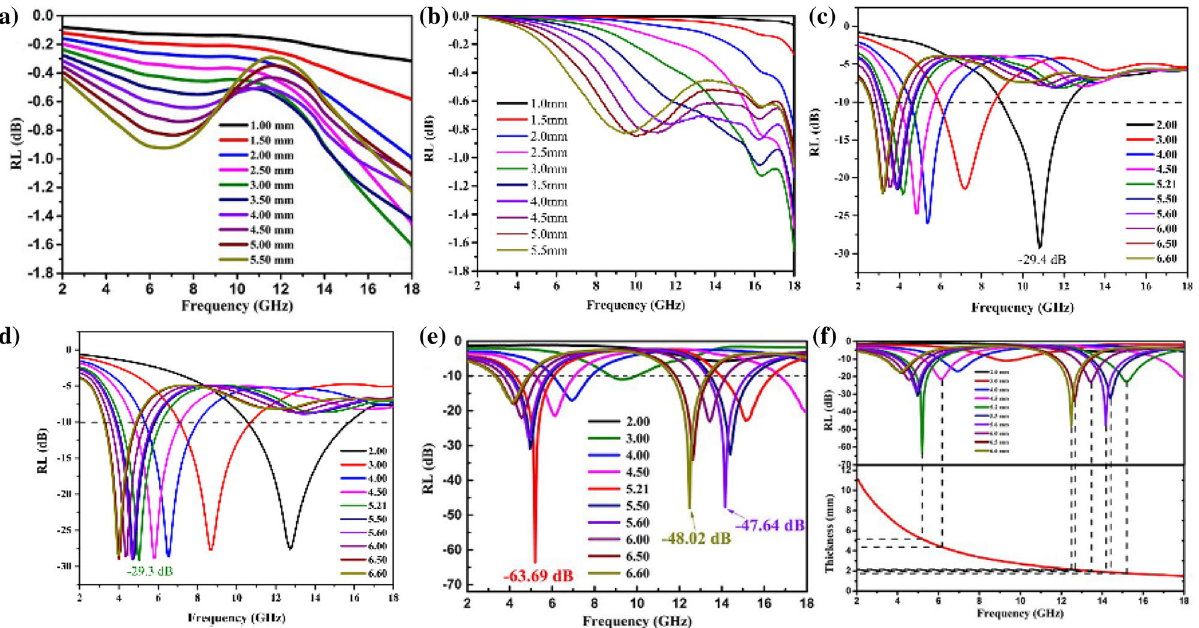
Figure 9. ( a ) Reflection loss (RL) curves for CoNPs, ( b ) Reflection loss (RL) curves for PCNF, ( c ) S1, ( d ) S2 and ( e ) S3 with different thickness in the frequency range of 2–18 GHz, ( f ) RL values of Co/PCNF at “matching thickness” (tm) in 2.00–18.00